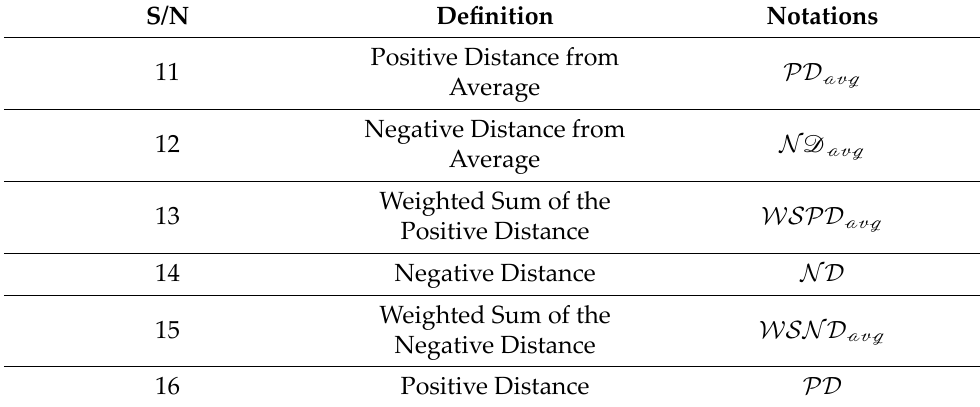
Table 2. Cont. S/N Definition